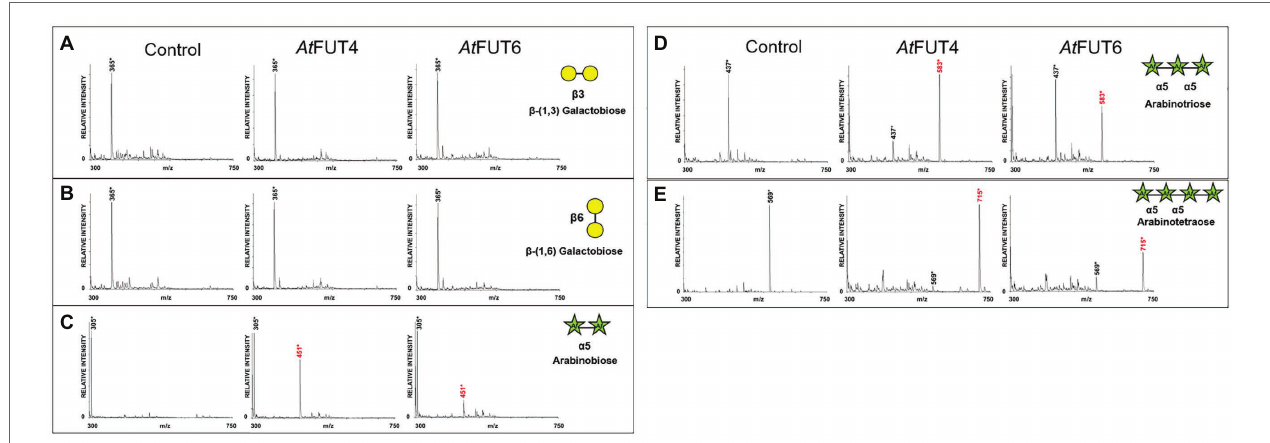
FIGURE 6 | MALDI-TOF MS analysis of products generated by incubating GFP- At FUT4, and GFP- At FUT6 with GDP-Fuc and different linear arabinan or galactan acceptor substrates. (A) β -(1,3)-linked galactobiose, (B) β -(1,6)-linked galactobiose, (C) α -(1,5)-linked arabinobiose, (D) α -(1,5)-linked, arabinotriose, and (E)